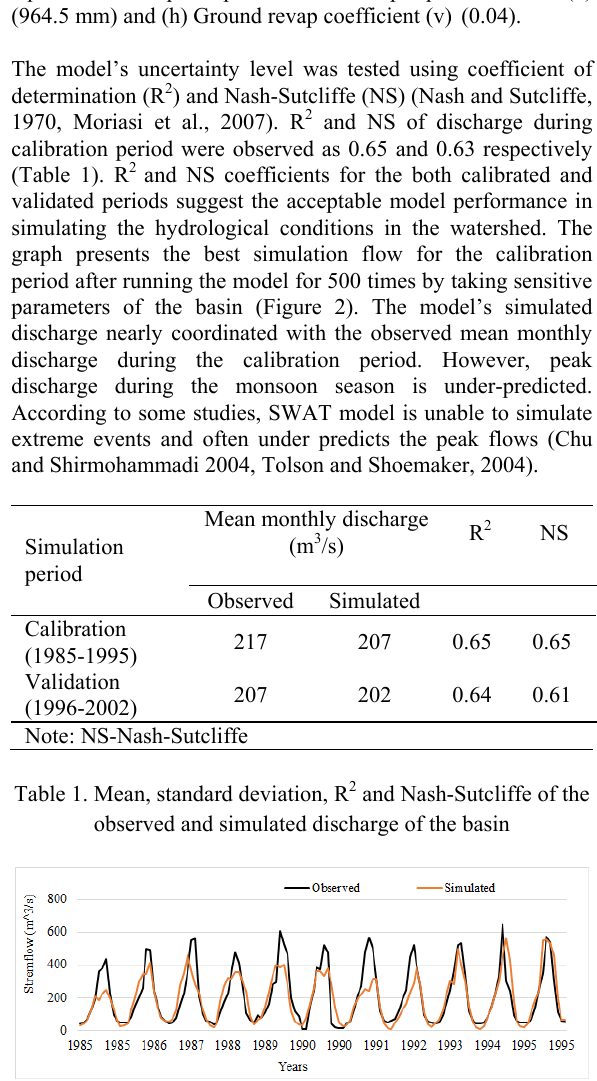
Figure 2. Model calibration results at Thalout in the upper Beas